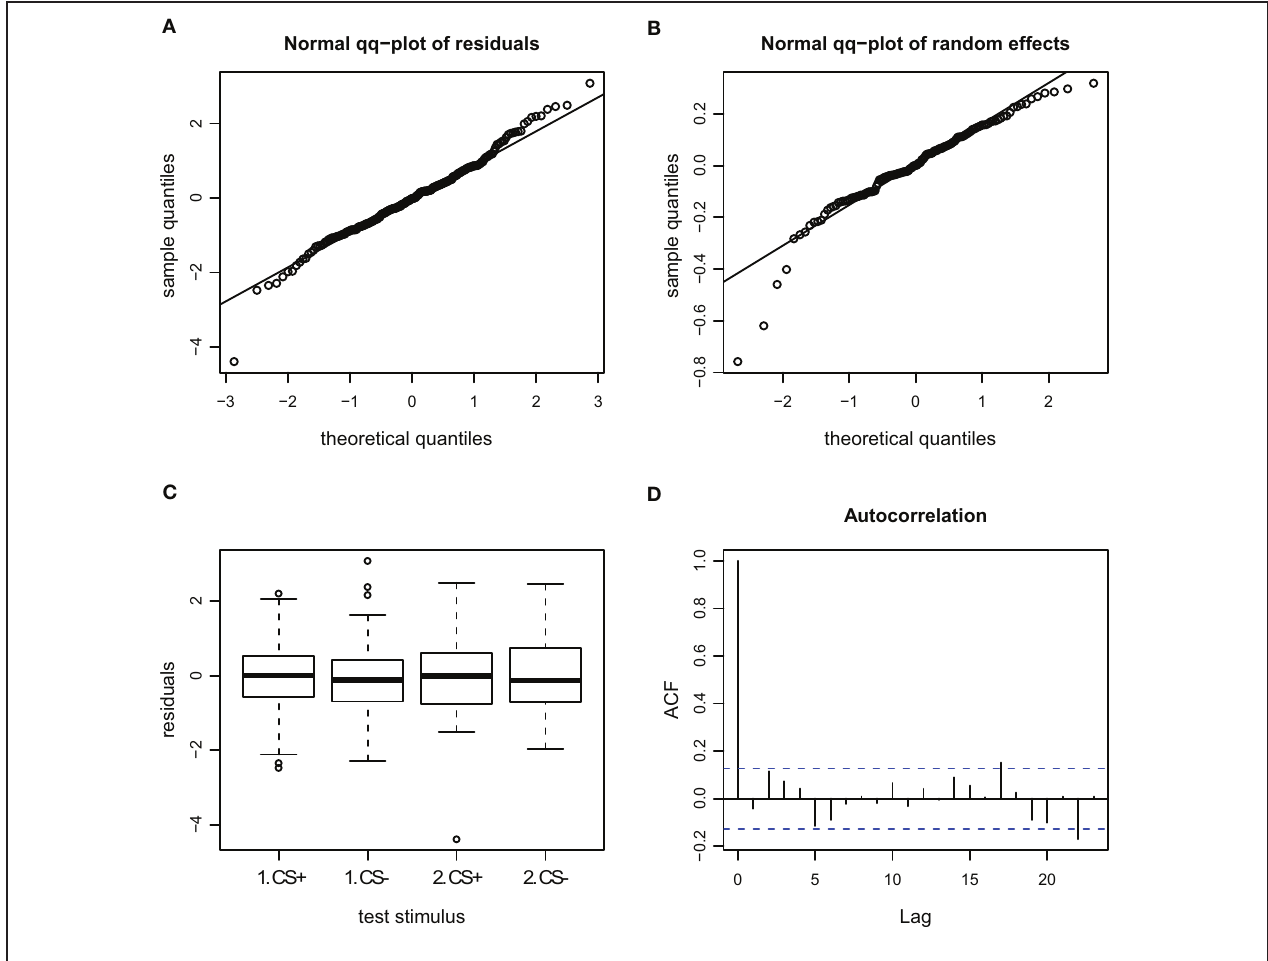
residuals of the velocity among the tested bees in the escape subset follows a normal distribution. (C) Boxplot of residuals of the velocity for the test trials from the escape subset indicates that the residuals within each testing group are symmetrically distributed around the predicted means (which are aligned to y = 0). (D) Autocorrelation plot of the deviance residuals (first bar indicating the residual correlated with itself). The following bars each indicate correlation to the previous residual. No auto-correlation can be observed in the fitted